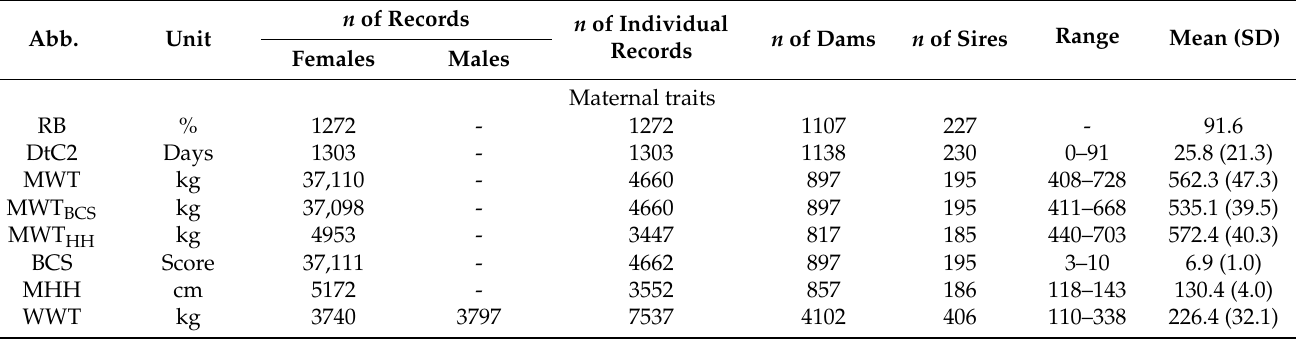
Table 2. Trait abbreviations (Abb.), numbers ( n ) of records, individual animals, sires and dams, range of measurements, means and standard deviations (SD) after adjustments and